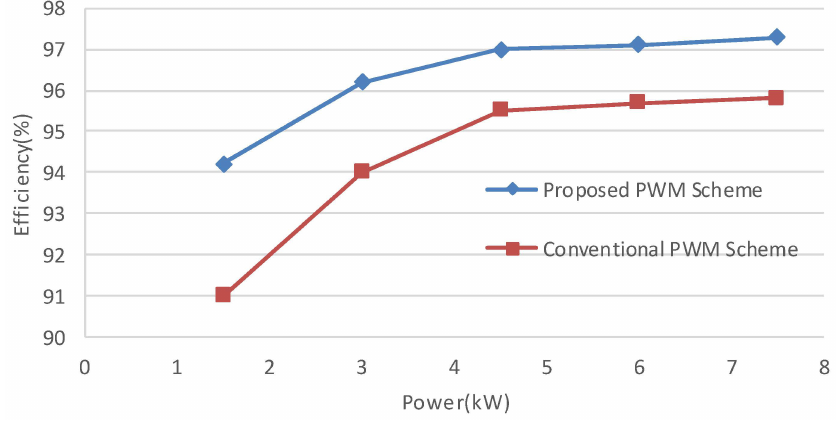
Figure 19. ZSI efficiency curves when using the proposed PWM scheme and the conventional PWM